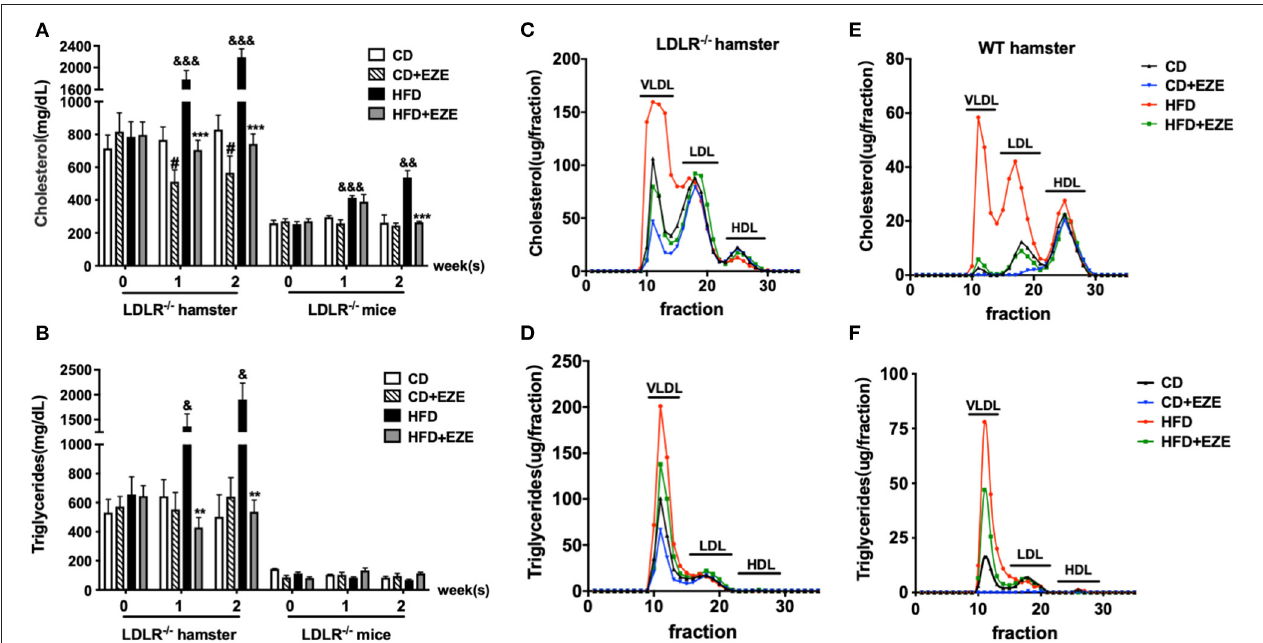
FIGURE 1 | The responses to high-fat diet (HFD) and ezetimibe (EZE) in hamsters and mice. Total cholesterol (A) and triglyceride (B) levels were determined from plasma collected after 2 weeks of HFD and EZE treatment from LDLR − / − hamsters ( n = 10) and mice ( n = 5). Data are shown as mean ± SEM. # p < 0.05 CD+EZE vs. CD; & p < 0.05, && p < 0.01, &&& p < 0.001 CD vs. HFD; ** p < 0.01, *** p < 0.001 HFD + EZE vs. HFD, where a two-way ANOVA with Tukey’s multiple comparisons test was performed. Lipid profiles of LDLR − / − (C,D) and WT (E,F) hamsters. The plasma lipoprotein profile of hamsters 2 weeks after different treatments (CD, CD ± EZE, HFD, HFD ± EZE) was analyzed by FPLC. Each sample was of pooled plasma of five hamsters in each group, and 100 µ L of the sample was loaded into the column. The cholesterol (upper) and triglycerides (bottom) of every collected fraction were determined and each data point was connected to make a curve on the graph. Each peak represents chylomicrons/VLDL, LDL, HDL fractions, respectively, from left to